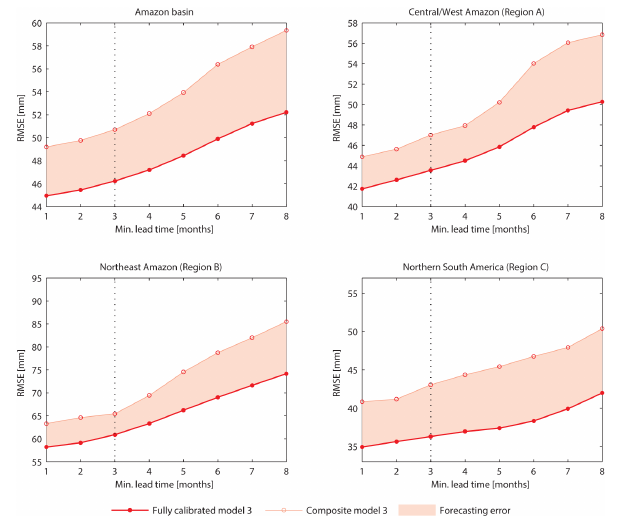
Figure 8. RMSE versus prescribed minimum lead time for the combined model, either fully calibrated (red line with full circles, same as in Fig. 6) or the composite time series (light red line with open circles), averaged over each of the three regions delineated in Fig. 1a. The difference between the two RMSEs is the forecasting error (shaded area). The vertical dotted line represents the minimum lead time that was used to display the forecasting error spatial dis- tribution shown in Fig.